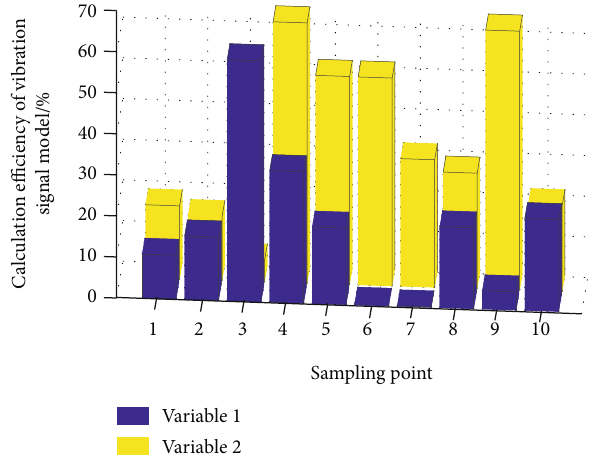
Figure 2: The calculation e ffi ciency histogram of the vibration signal